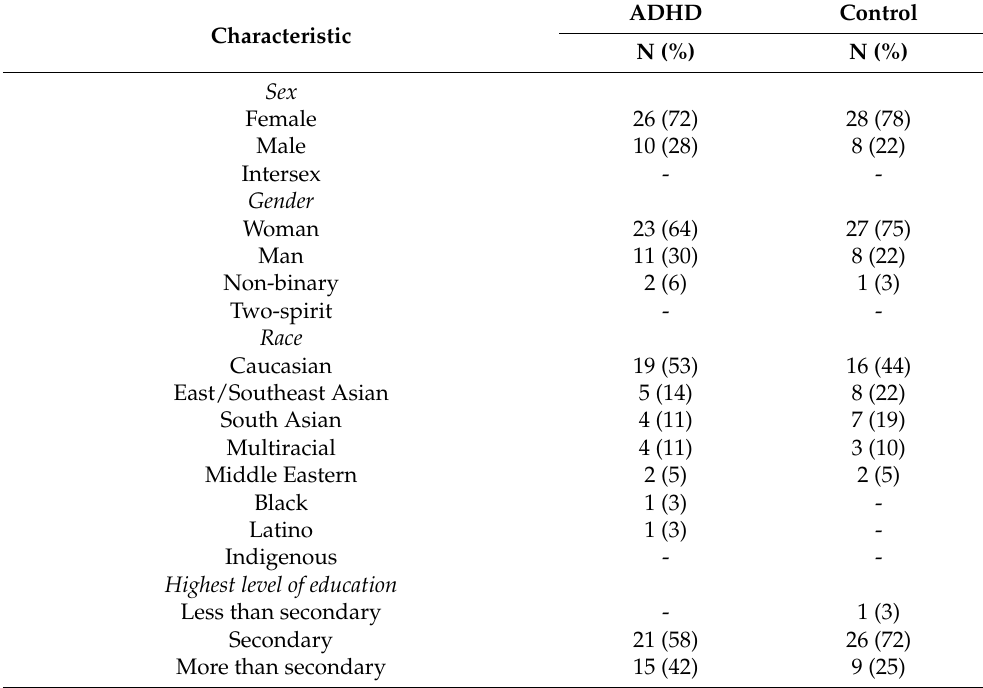
Table 1. Demographic Characteristics.